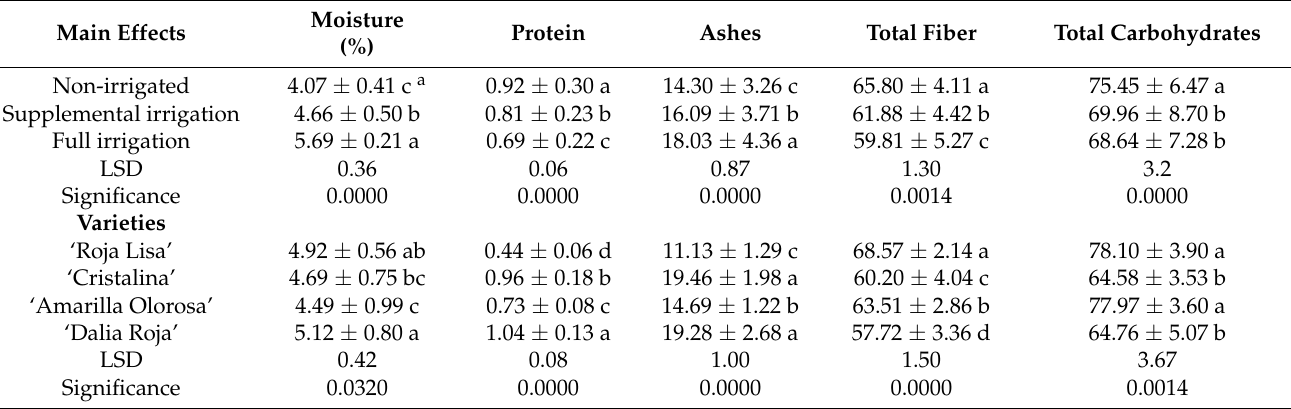
Table 3. Chemical composition of freeze-dried mucilage extracted from cladodes of Opuntia varieties subjected to irrigation